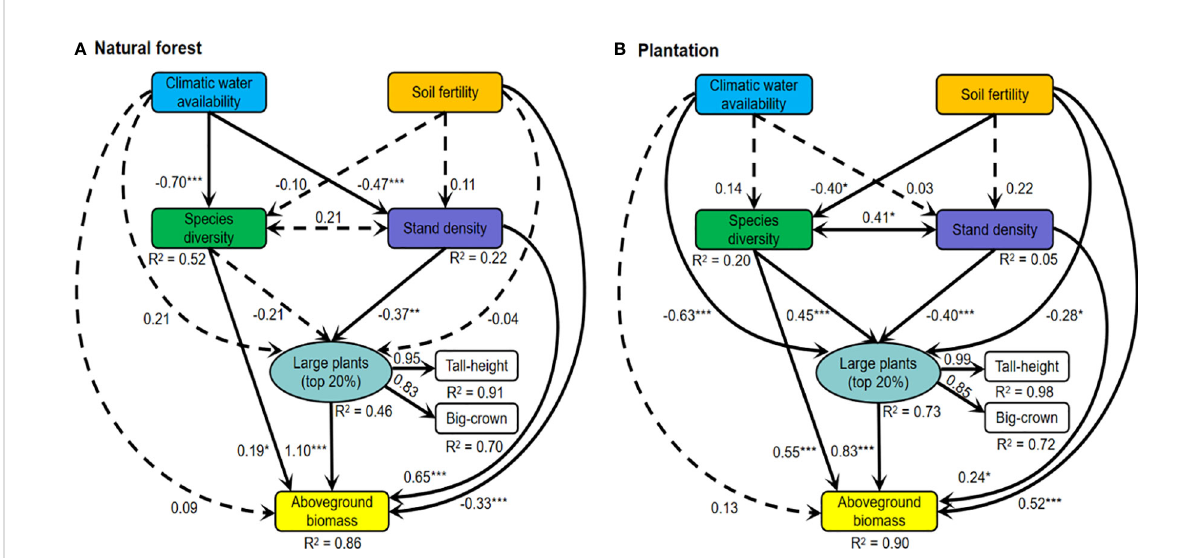
FIGURE 3 Structural equation models for linking climatic water availability, soil fertility, large plants (a latent variable of tall stature and big crown; indicated the in fl uences of big-sized trees on ecosystem function and structure), species diversity, stand density, and aboveground biomass in (A) natural forest and (B) plantation of the arid temperate region in China. Solid lines represent signi fi cant paths ( p < 0.05), while dashed lines indicate nonsigni fi cant paths ( p > 0.05). The con fi dence degree of the relationship between two paired variables at less than *0.05, **0.01, and ***0.001, respectively. For each path, the standardized regression coef fi cient is shown (Supplementary Tables S3, and S4). Model- fi t statistics for (A) : comparative fi t index (CFI) = 0.953, goodness-of- fi t index (GFI) = 0.941, and the standardized root mean square residual (SRMR) = 0.052; (B) :